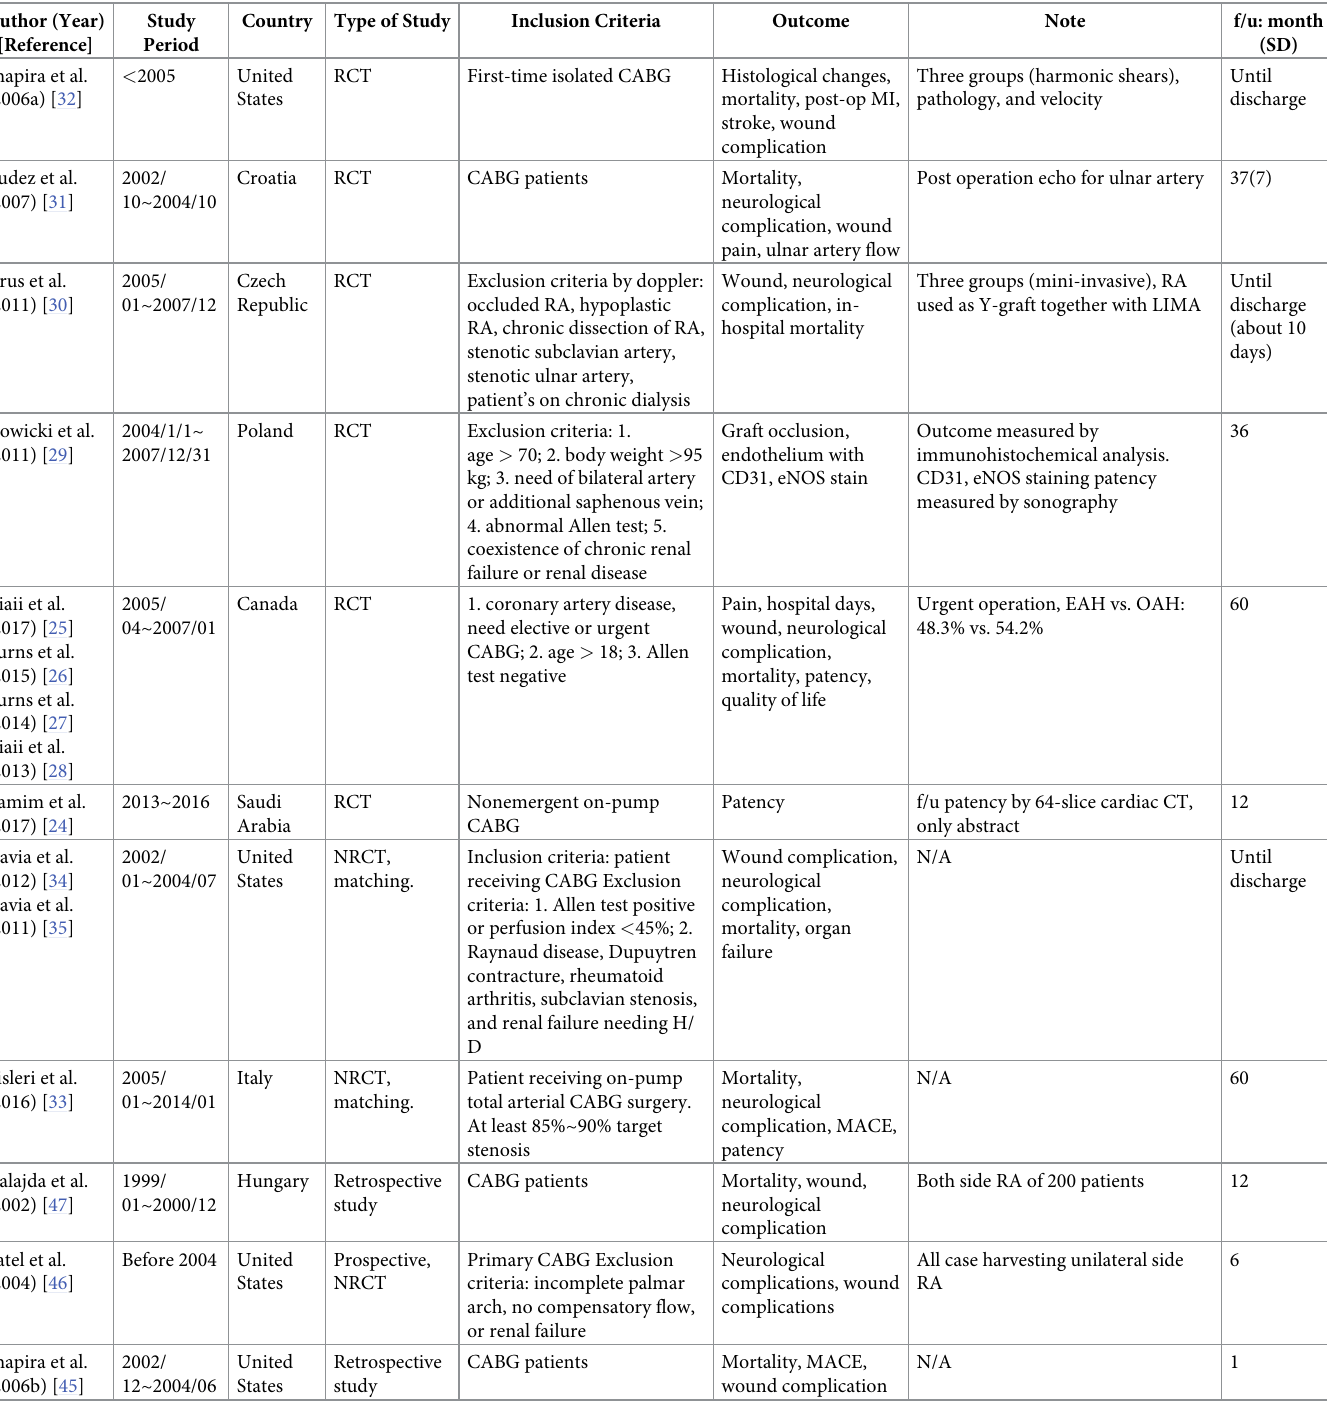
Table 1. Randomized control trail comparing endoscopic and conventional radial artery